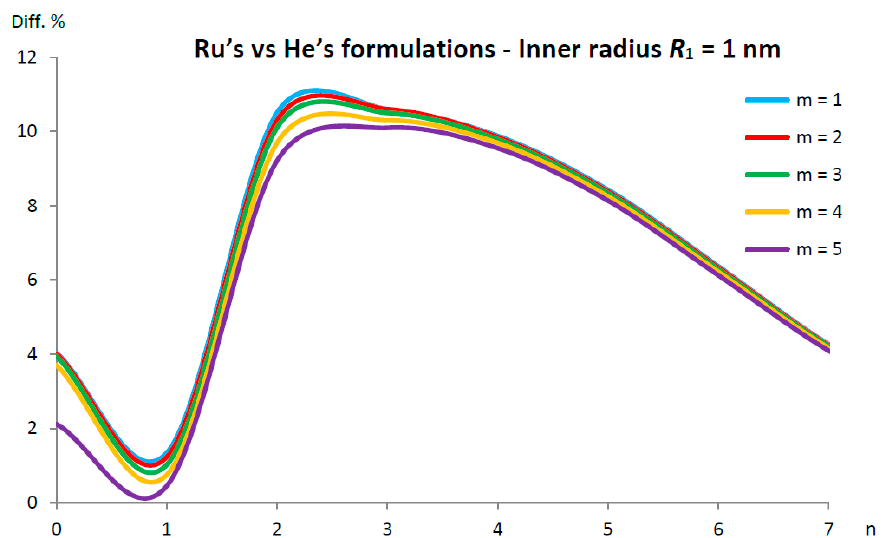
Figure 5. Percentage differences between the highest radial natural frequencies of the simply sup- ported DWCNT of Table 1 with inner radius R 1 = 1 nm and aspect ratio L / R 2 = 10 from Ru’s (38) and He’s (39) formulations. Donnell shell theory. Anisotropic elastic shell model. Number of longitudinal half-waves m . Number of circumferential waves n .